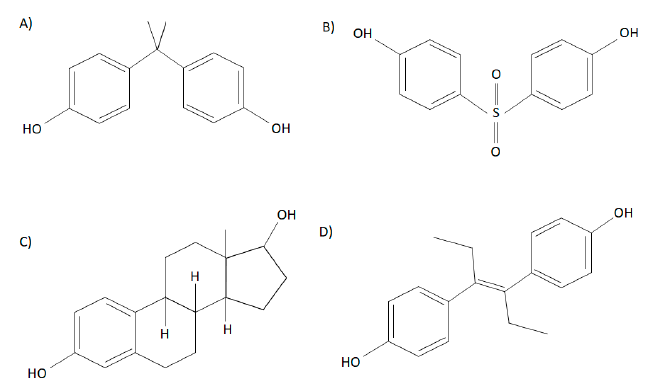
Figure 1. Chemical structure of Bisphenol A (BPA), bisphenol S (BPS), 17 β -estradiol (E2), and diethylstilbestrol. ( A ) BPA is a dimethyl derivative and contains two hydroxyphenol groups. ( B ) BPS is a sulfonyl derivative and contains two hydroxyphenol groups. ( C ) E2 is a sex hormone that is derived from cholesterol and contains a hydroxyphenol group that interacts with the estrogen receptor (ER). ( D ) Diethylstilbestrol is a synthetic estrogen that contains two hydroxyphenol groups.